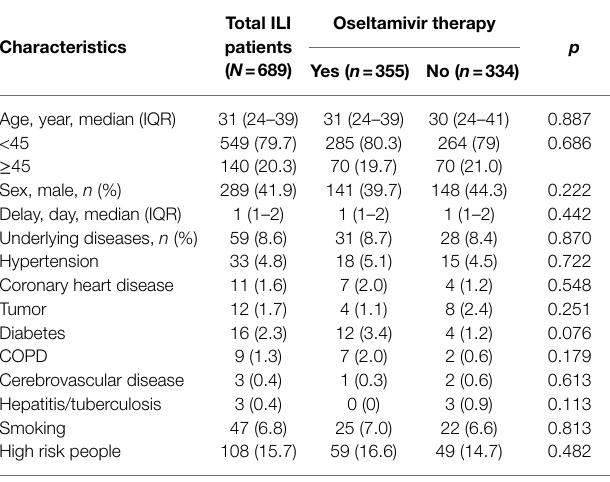
TABLE 1 | The characteristics of the influenza-like illness (ILI) patients with or without oseltamivir therapy.